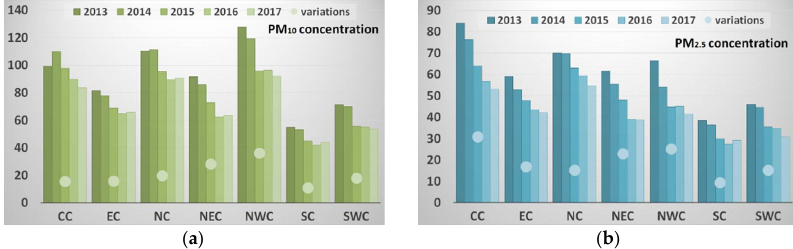
Figure 5. The overall variations of PM 10 and PM 2.5 concentrations in different regions of China from 2013 to 2017. The histogram represents mean PM concentration (μg/m 3 ) and the circle refers to the difference between the annual mean PM concentration in 2017 and that in 2013.